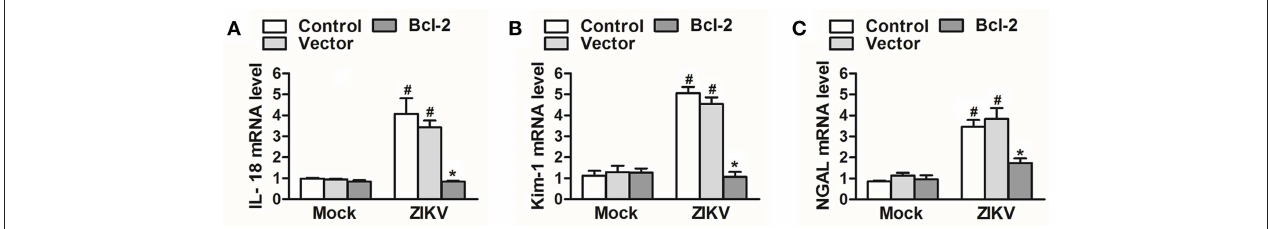
FIGURE 9 | Overexpression of Bcl-2 attenuated renal cell injury induced by ZIKV infection. (A–C) The relative mRNA levels of IL-18, NGAL, and Kim-1 were determined by qRT-PCR. Data were presented as mean ± SEM, * p < 0.05 vs. Control group; # p < 0.05 vs. mock group. overexpression of Bcl-2 extremely decreased IL-18, NGAL, and kim-1 mRNA expression levels in HK-2 cells infected with